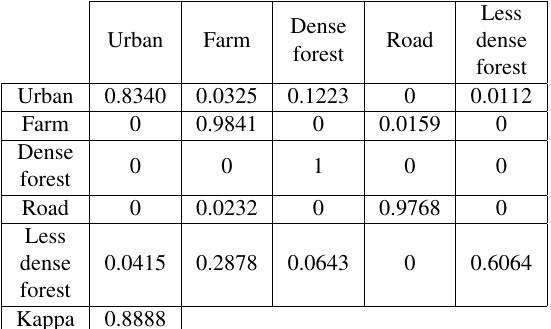
Table 2. Improved Freeman-GMM confusion matrix